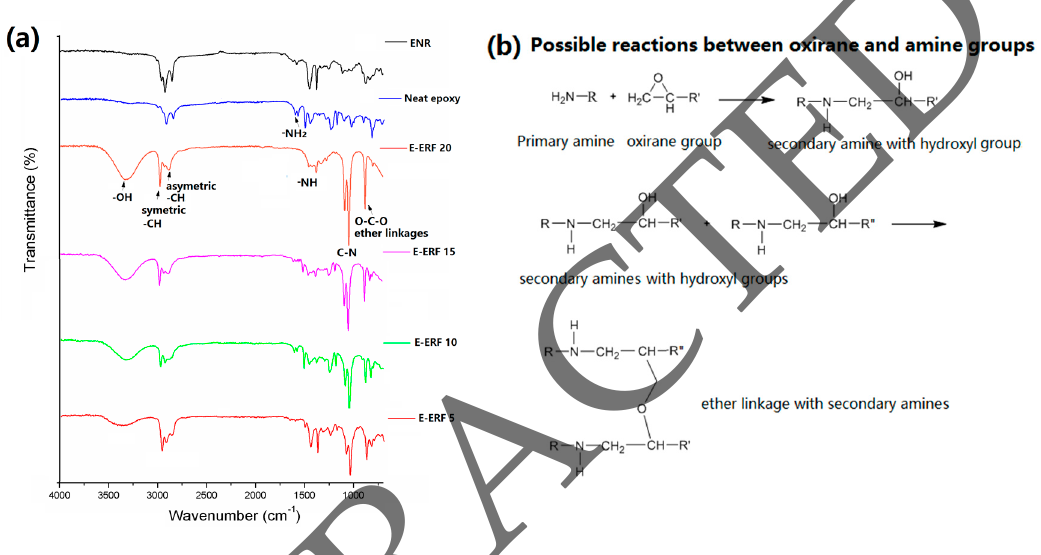
Figure 4. ( a ) ATR-FTIR spectra of neat epoxy resin, neat ERFs and all E-ERF resins; ( b ) possible reactions between oxirane group and amine to form the secondary amines with hydroxyl groups and two secondary amines form ether linkages in epoxy resin.